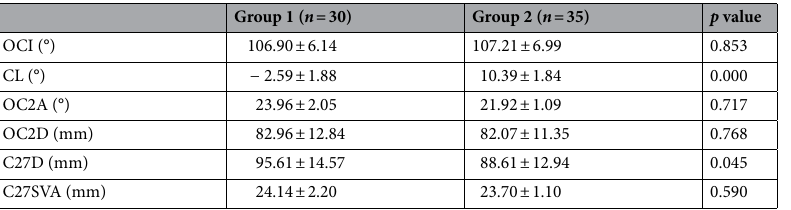
Table 4. Preoperative values of cervical sagittal parameters of both groups. All continuous values are in mean ± standard deviation. OCI, occipitocervical inclination; CL, cervical lordosis; OC2A, occiput-C2 angle; OC2D, occiput-C2 spinous process distance; C27D, C2-C7 interspinous process distance; SVA, C2-C7 sagittal vertical axis. p value below 0.05 indicates statistically significant difference between two groups.